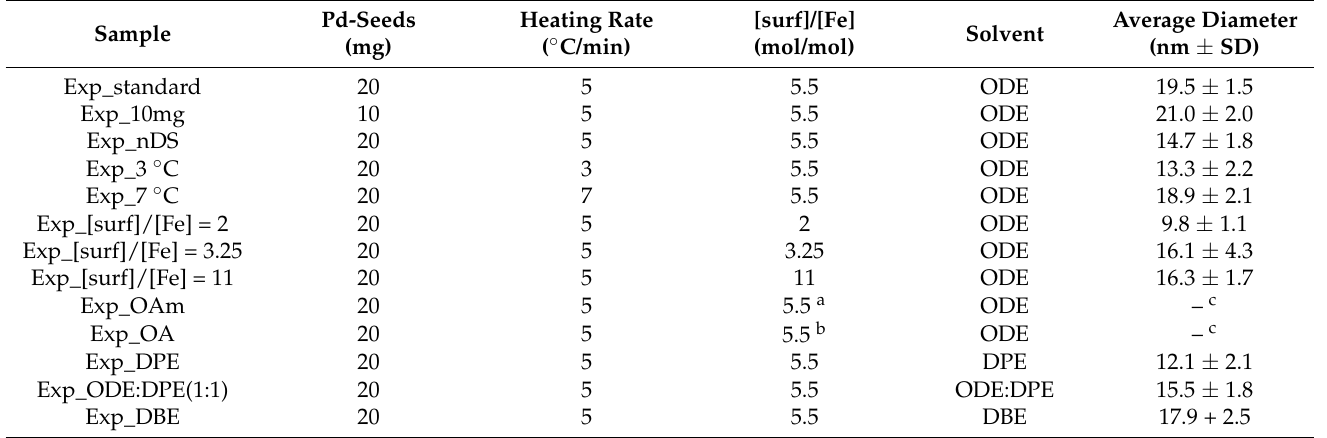
Table 1. Summary of the synthetic conditions in seed-mediated synthesis of Pd/Fe-oxide NPs and the resulting average